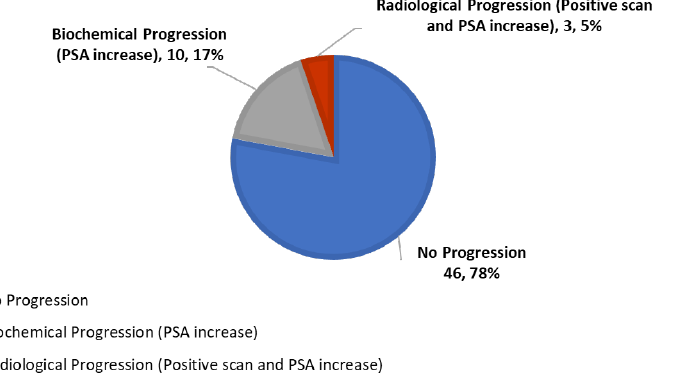
Figure 2. Response to therapy, no progression defined as a decreased/stable PSA and/or improve- ment of PSADT ( n , %).